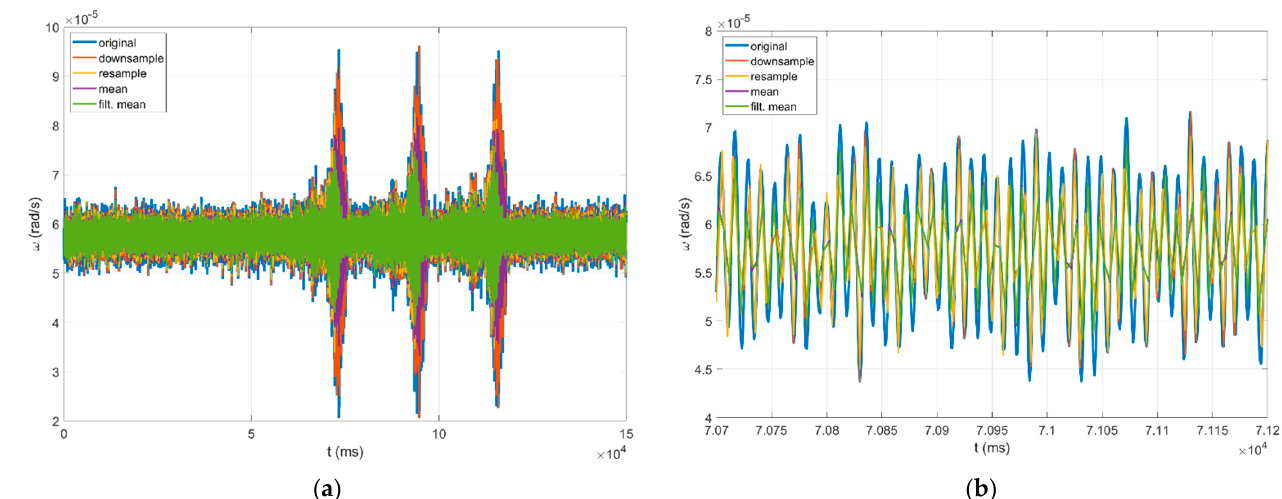
Figure 5. Seismogram of rotational events recorded by the FOS5-02 during the Fürstenfeldbruck experiment on 21 November 2019, for a series of three sweep sine vibrations generated by a special VibroSeis truck (peak force: 275 kN) provided by a TU Bergakadennie Freiberg: ( a ) recorded signal for a series of three sweep sine generations, and ( b ) a window magnifying the first of the events. Different colours show the results of the application of different resampling methods with their identification presented in the top-left window.